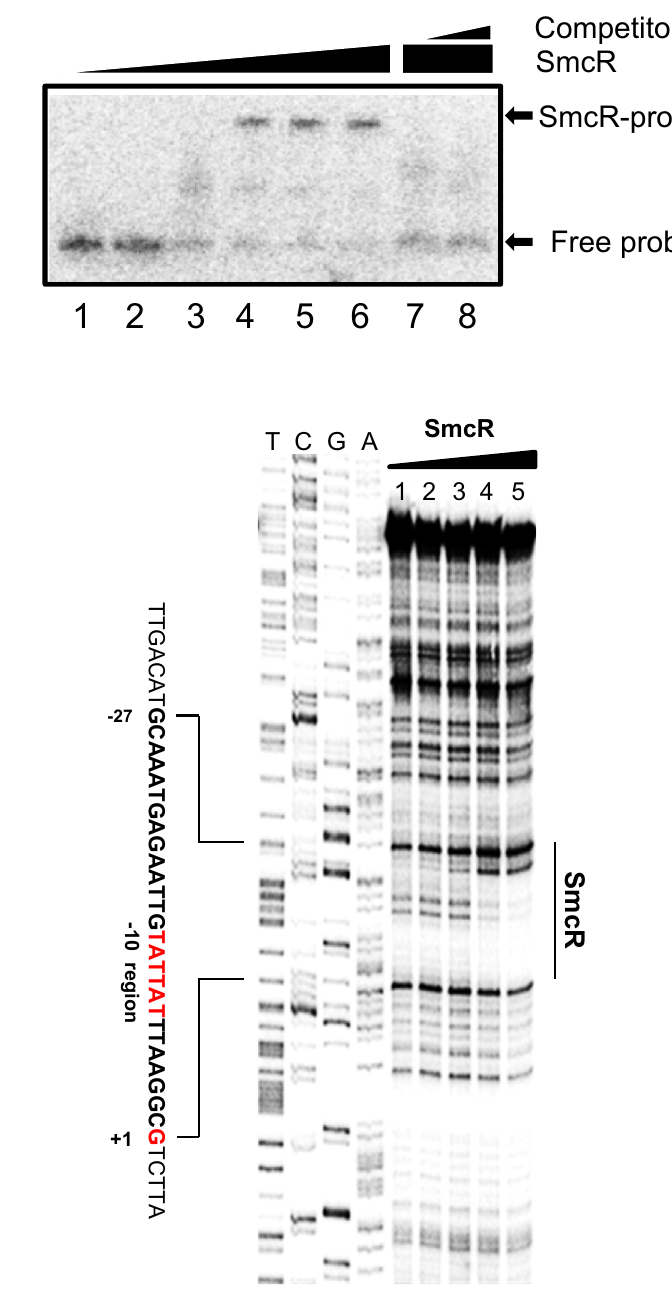
Figure 4. SmcR binds directly to the upstream region of ryhB . ( a ) Gel mobility shift assay of purified SmcR binding to a DNA fragment of the upstream region of ryhB . Lanes 1 to 6 represent 20 ng of 32 P-labeled ryhB probe incubated with 0, 50, 100, 150, 200, and 300 nM of SmcR, respectively. Lanes 5 and 6 represent 20 ng of the labeled ryhB probe incubated with 250 nM of SmcR with the addition of either 260 ng or 780 ng of unlabeled probe as a competitor, respectively. ( b ) DNase I footprinting to identify the SmcR binding site in the region upstream of ryhB . 32 P-labeled ryhB probe (100 ng) with SmcR at 0, 62.5, 125, 250, 500 and 1000 nM is included in lanes 1 to 5, respectively. Sequencing ladders were included for